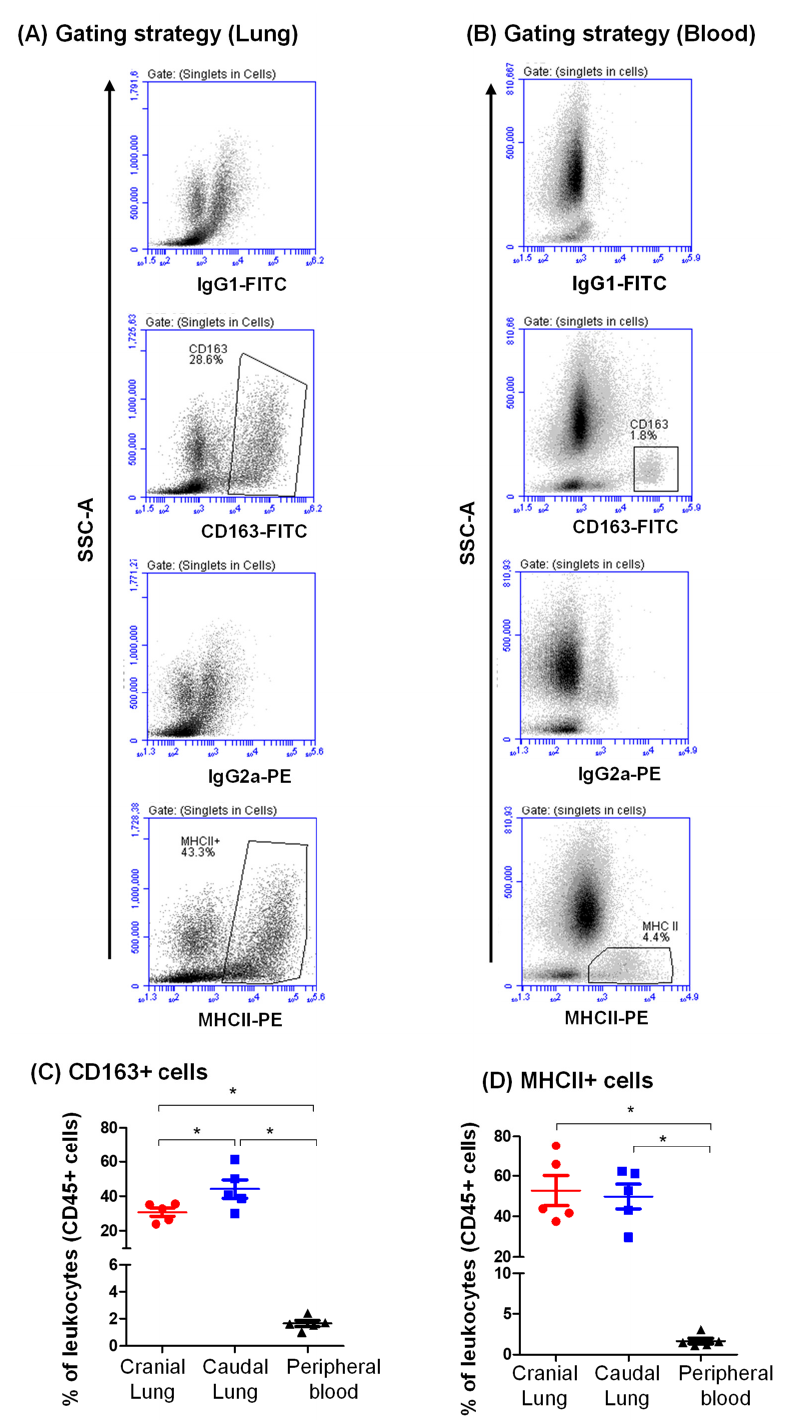
Figure 3. Flow cytometric analysis of the expression level of CD163 ( A ) and MHCII ( B ) on lung and blood leukocytes. ( A ) Lung cells and blood leukocytes were labeled with monoclonal antibodies to CD163 and MHCII molecules or with isotype control antibodies, and labeled cells were analyzed by flow cytometry. The percentage of CD163-positive cells within lung cells and blood leukocytes was identified in an SSC against CD163 dot plot. The percentage of MHCII-positive cells within lung cells and blood leukocytes was identified in an SSC against MHCII dot plot. ( C ) Data of CD163 ( C ) and MHCII ( D ) expression were presented graphically for cranial and caudal lung tissue and peripheral blood leukocytes. * indicates a significant difference between the two groups ( p <